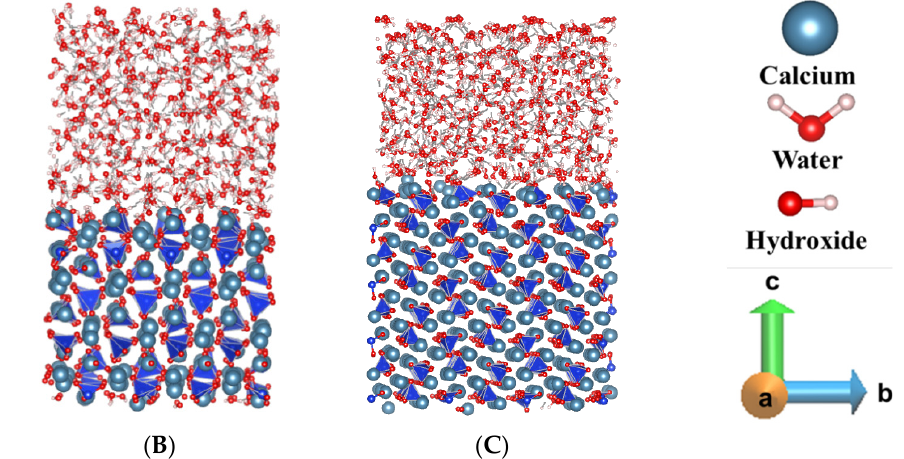
Figure 2. Representative snapshot for comparing the reactivity between the β -C 2 S facets: ( A ) (100), ( B ) (001), ( C ) (010) after pre-hydration for 600 picoseconds at 298 K.